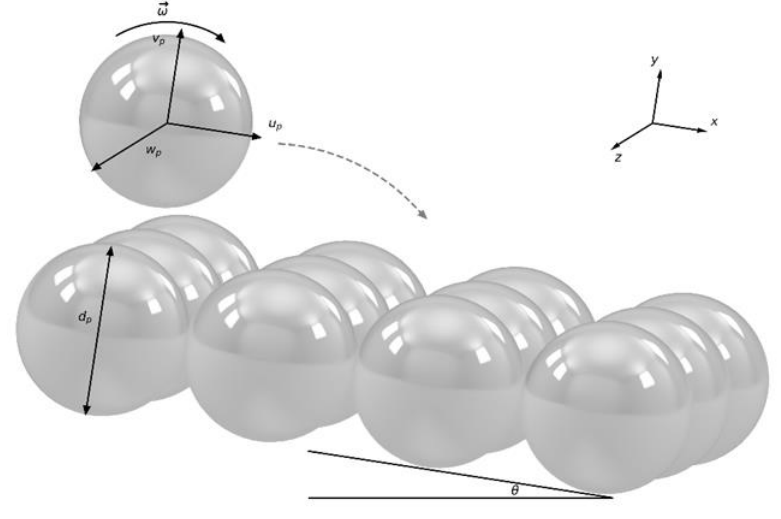
Figure 1. Schematic of the 3D particle jumps.